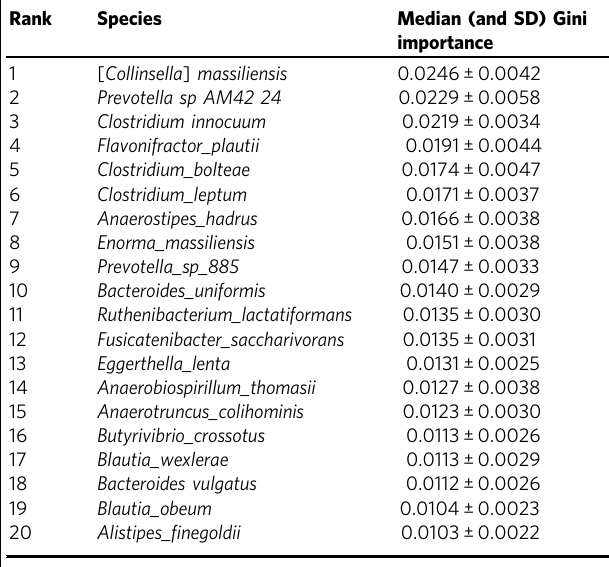
Table 1 Most important species to discriminate Nunavik gut microbiome composition from comparison groups identi fi ed by random forest classi fi er, ranked based on median Gini